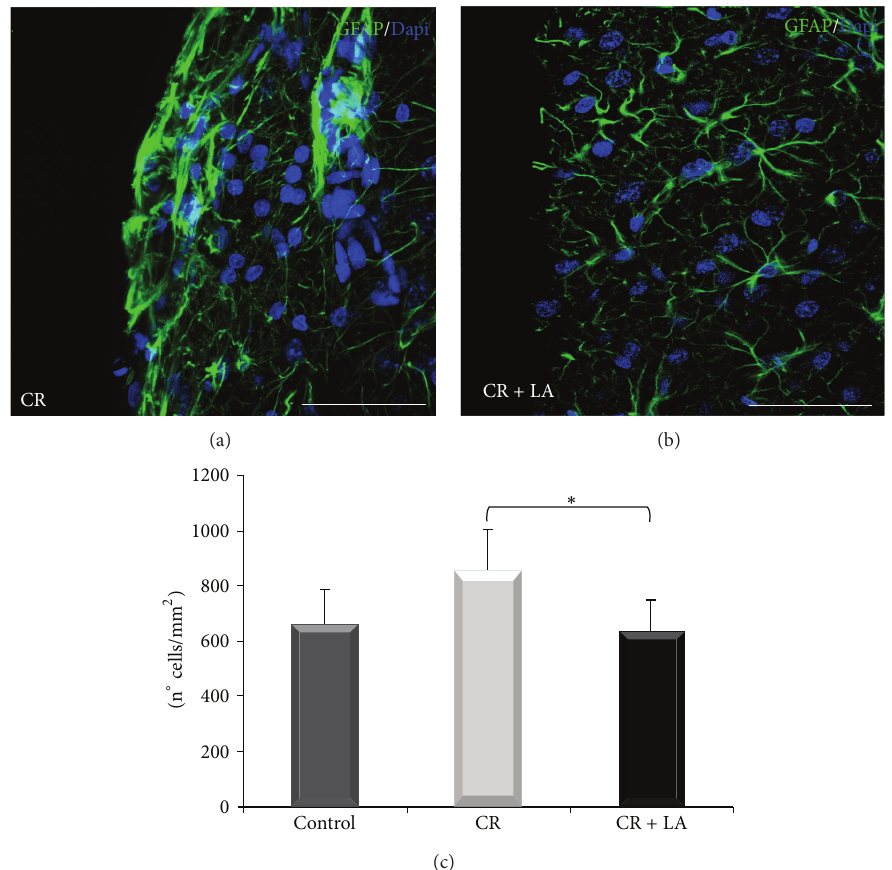
Figure 2: Immunofluorescence for GFAP (astrocytes in green) in nontreated animals (a) and LA treated animals (b), 60 days after the brain cryoinjury. Nuclei become evident with Dapi (blue). Quantification of astrocyte cell density (n ∘ cells/mm 2 ) (c) Scale bar: 50 𝜇 m. ∗ 𝑃 < 0.05